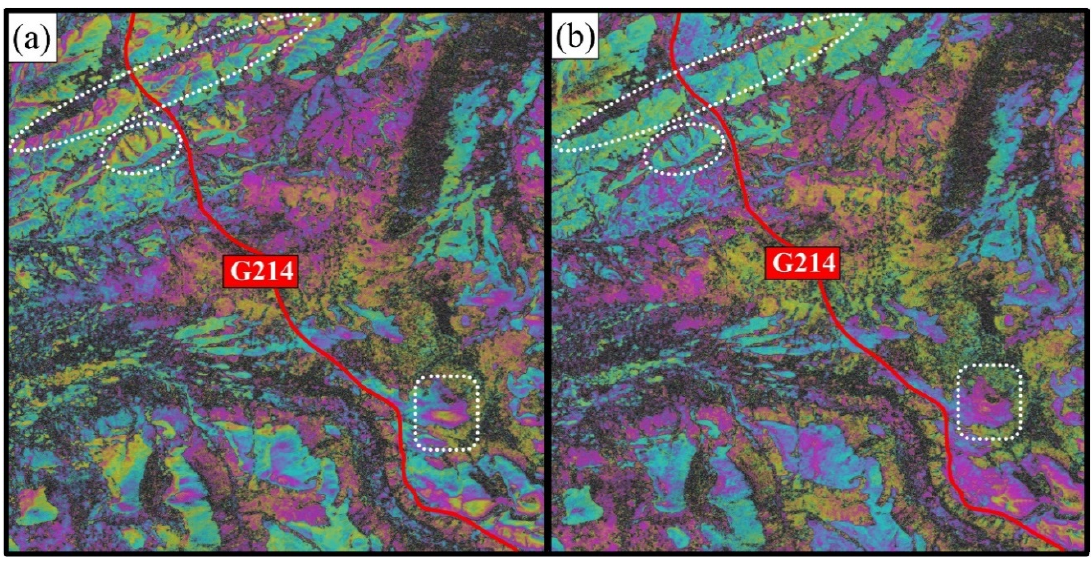
Figure 3. The comparison of interferograms after removing the topographic effect with ( a ) SRTM DEM; ( b ) Reference 3D DEM. The red line denotes the highway (based on SAR pixel coordinates).